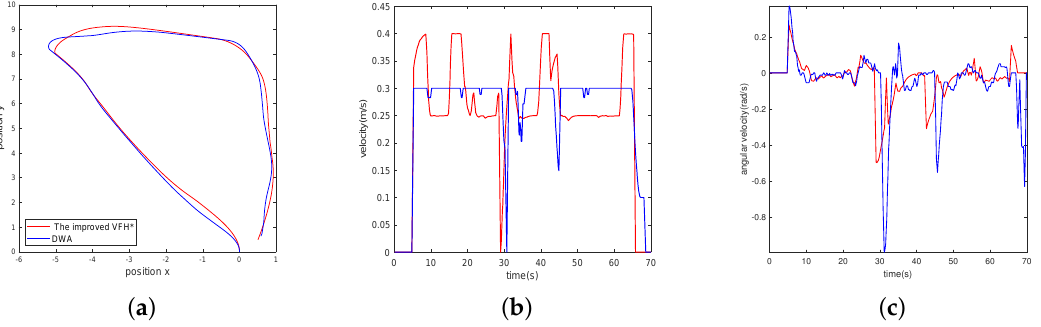
Figure 9. The results of different path planning methods were compared in the experiment I. ( a ) The trajectory comparison. ( b ) The velocity comparison. ( c ) The angular velocity comparison.